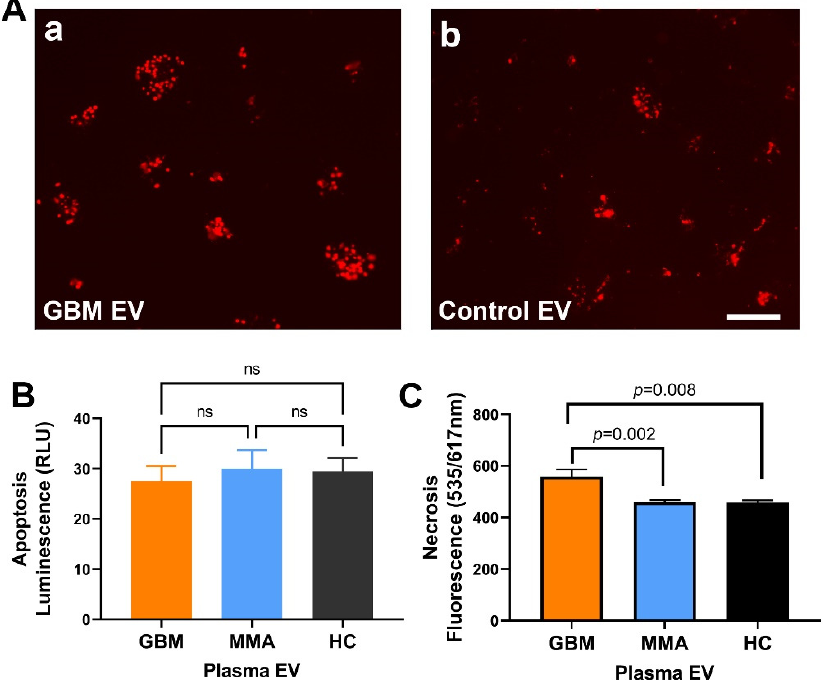
Figure 5. GBM EV induced necrotic cell death in neurons ( A ). Fluorescent microscopy shows higher neuronal death induced by GBM EVs. SH-SY5Y cells were treated with EVs for one hour. Cell death was monitored by propidium iodide. A higher number of neuron death was seen in GBM EVs ( A - a ) as compared to control EVs from an epithelial cell line ( A - b ). ( B ). GBM EV did not cause apoptosis in SH-SY5Y cells. SH-SY5Y cells were treated with GBM, MMA, or HC EVs for four hours, and apoptosis was measured by luminescence. Only minimal luminescence signals were detected in GBM, MMA or HC EV-treated cells, and there are no significant differences among different EVs (n.s., p > 0.1, n = 6 for GBM EV, n = 8 for MMA EV, n = 5 for HC EV). ( C ). GBM plasma EVs induced higher necrosis as compared to control EVs. SH-SY5Y cells were incubated with plasma EVs (2 mg/mL, GBM EV=14; MMA EV = 8; HC EV = 8) for 4 h. The necrotic cell death was monitored by PI red fluorescent reading. There were significantly higher levels of necrosis in GBM-EV-treated neurons compared to MMA EV and HC-EV-treated cells ( p = 0.002 and p = 0.008, respectively). Scale bar = 200 mm for ( A ).